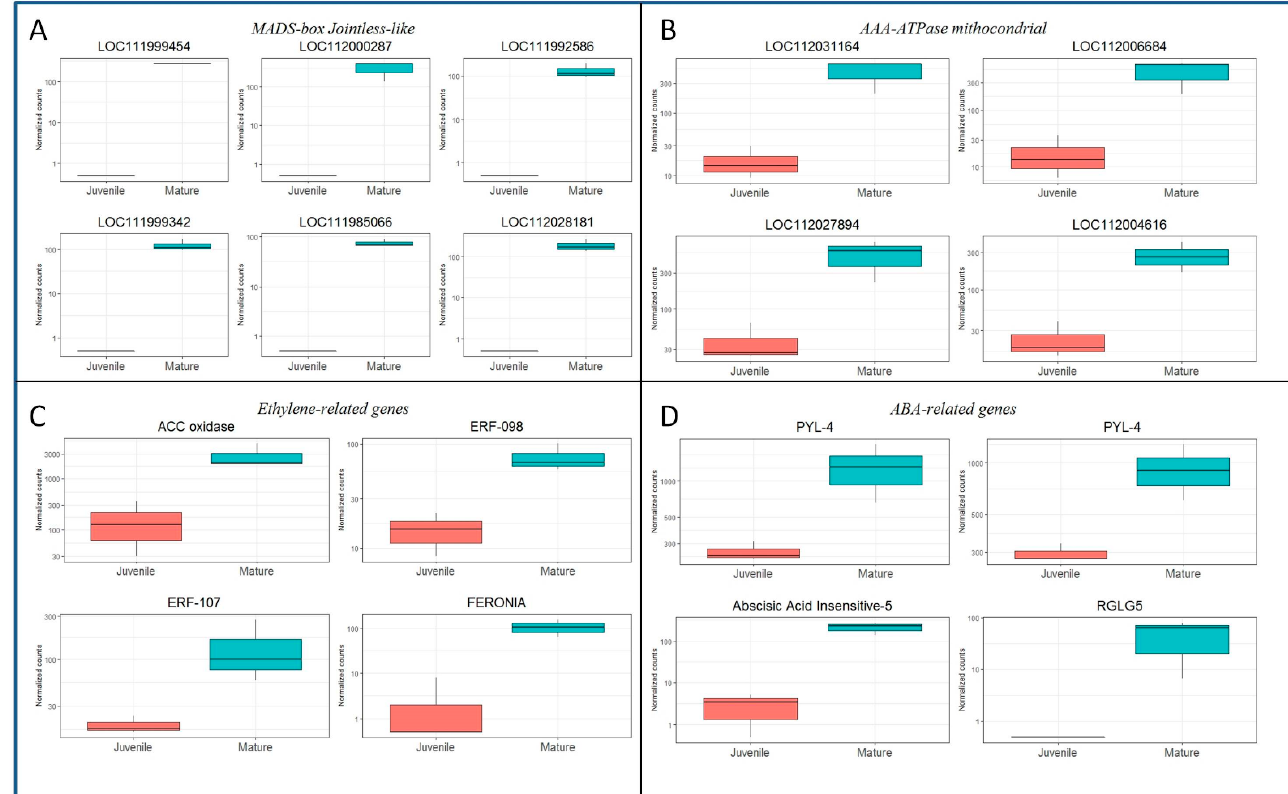
Figure 3. Boxplots showing the expression in normalized counts of DEGs detected in the CR samples versus their expression in BS samples. ( A ) Expression of six MADS-box Jointless-like genes. Gene symbols are given in the figure. ( B ) Expression of four AAA ATPase mitochondrial genes. Gene symbols are given in the figure. ( C ) Expression of ethylene-related genes: ACC oxidase , LOC111997351; ERF-098 , LOC112018069; ERF-107 , LOC112033868; FERONIA , LOC112001600. ( D ) Expression of Abscisic acid-related genes: PYL-4 , LOC111988217 and LOC112017749; ABSCISIC ACID-INSENSITIVE 5 protein 3 ( ABI-3 ), LOC112026097; RGLG-5 , LOC112025452.